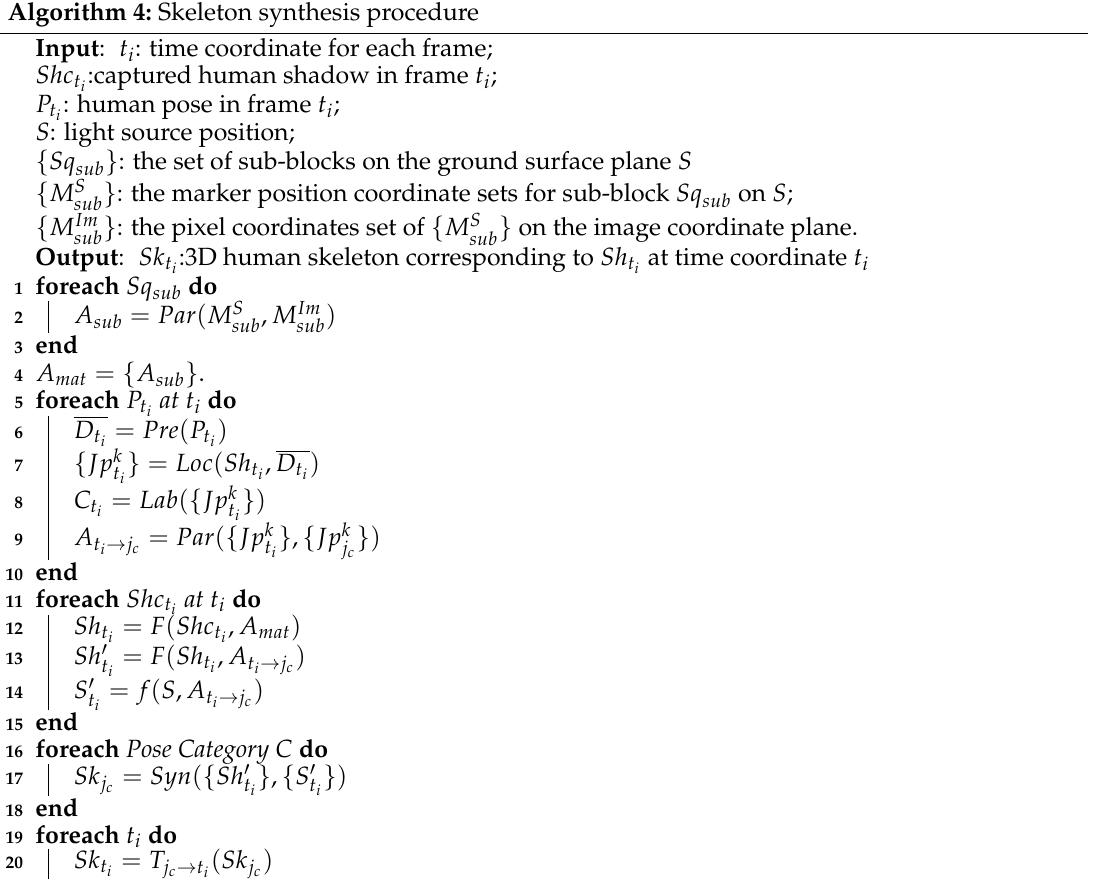
Algorithm 4: Skeleton synthesis